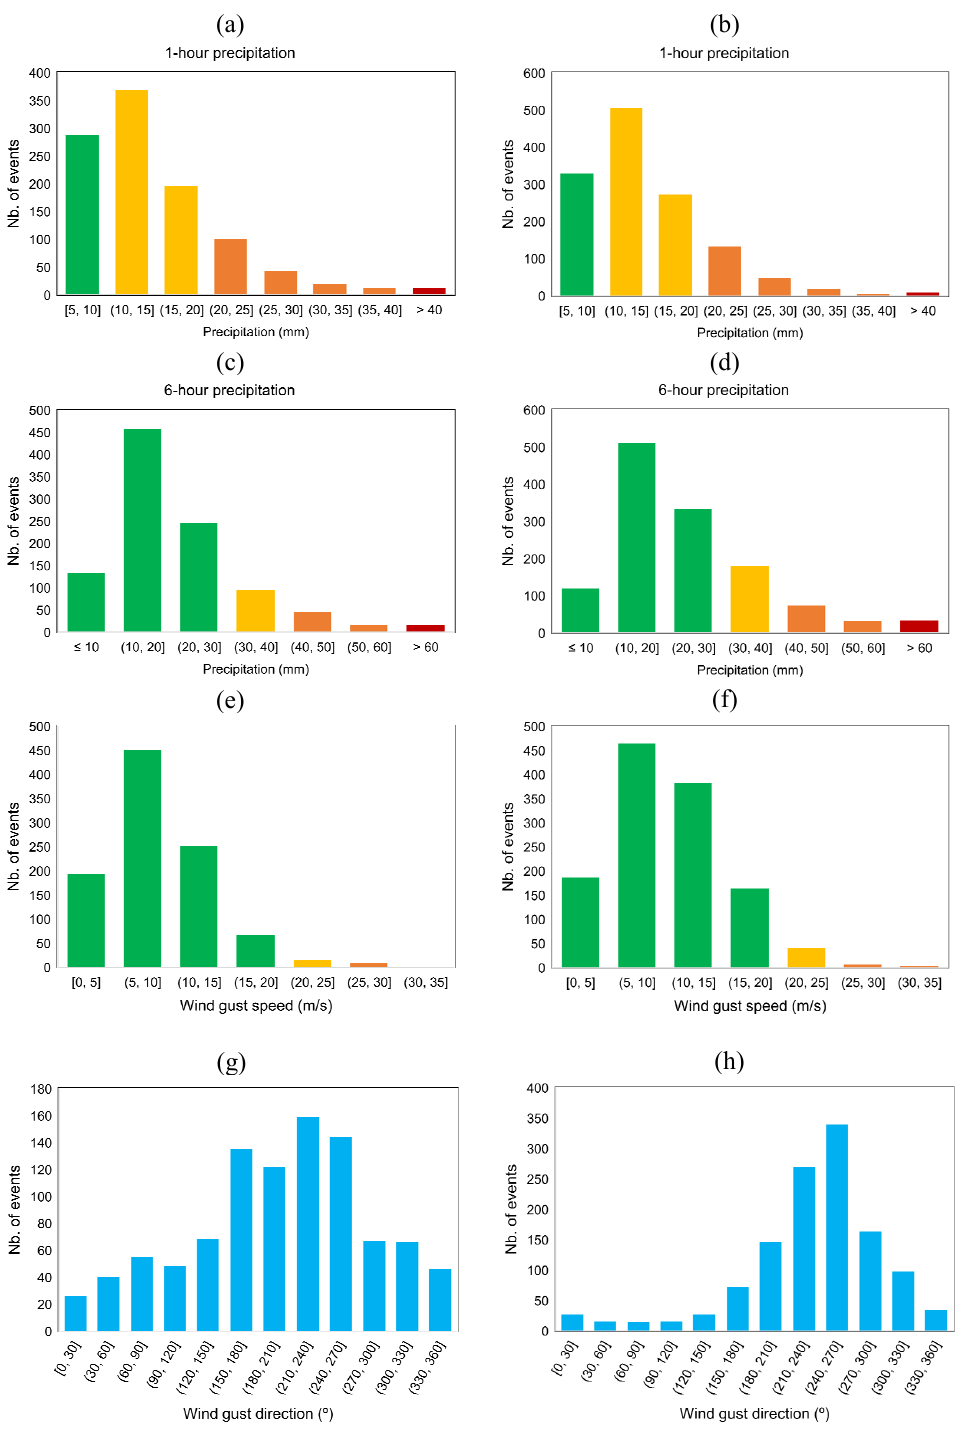
Figure 6. Distribution of the (a,b) 1-hour precipitation, (c,d) 6-hour precipitation, (e,f) wind gust speed and (g,h) wind gust direction recorded at the weather stations at the occurrence of the sub-hourly extreme precipitation events, and separately by class (left panels: RegL, right panels: RemL). In all panels except for wind gust direction, colors correspond to the respective severe weather warning scale in use by the Portuguese weather service (yellow, orange and red, green for no warning being issued).